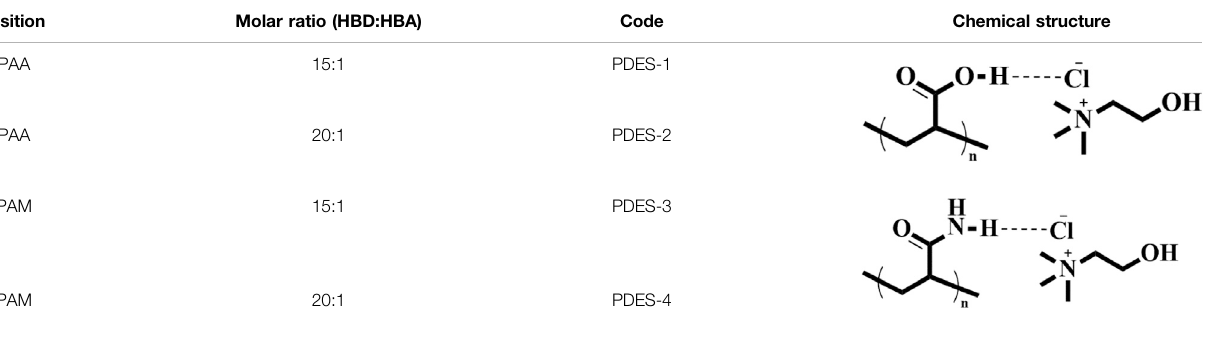
TABLE 1 | Composition and nomenclature of the synthesized PDESs.